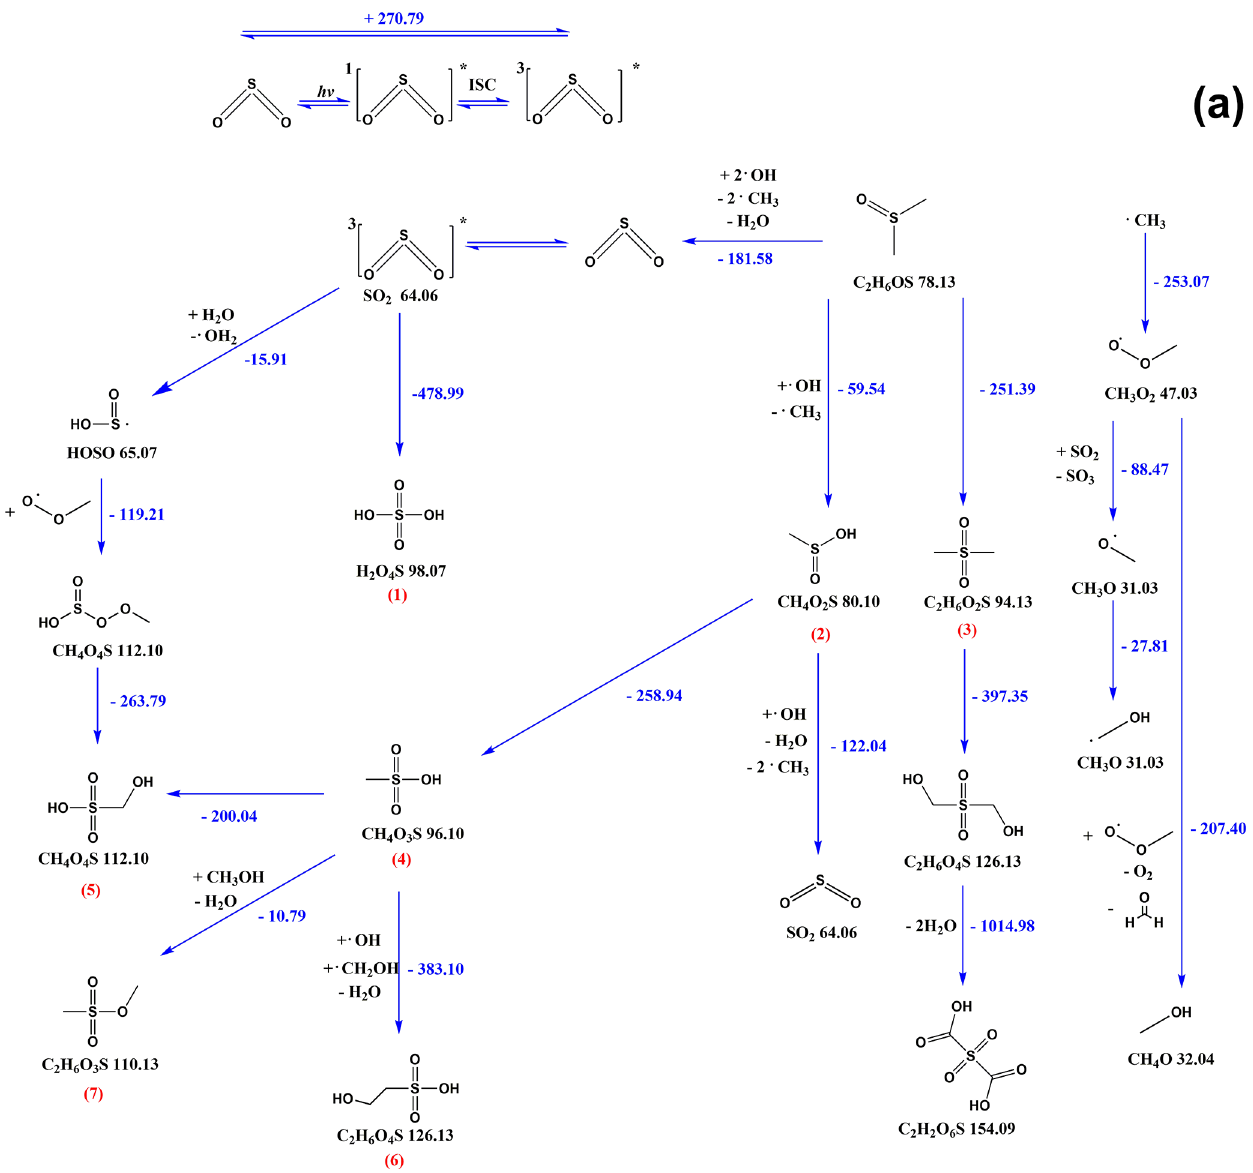
Krevelen (VK) plots for all CHOs and CHOSs formed during light-induced SO 2 oxidation of PAHs/DMSO are shown in Fig. 3. The CHO and CHOS compounds formed during the reac- tion of SO 2 with DMSO in the dark and under irradiation are shown in the VK plot depicted in Fig. S8. The same classes of compounds, detected upon heterogeneous reactions of SO 2 with PAHs/DMSO under irradiation are illustrated in the VK plots depicted in Figs. S9 and S10, respectively. Most of the CHO and CHOS products identified with DMSO had high H / C ratios (1.5–2.1) but O / C ratios lower than 0.4, sug- gesting the formation of aliphatic compounds (Mekic et